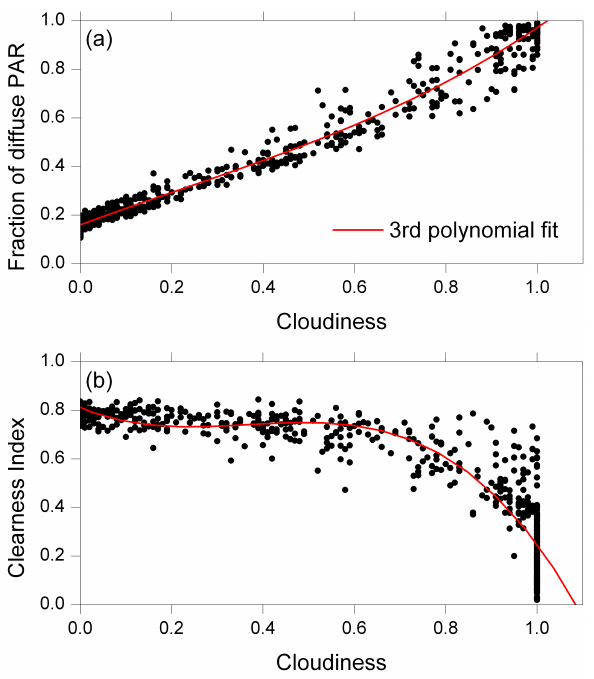
Fig. 6. Relationships between fraction of diffuse PAR (a) , clearness index (b) and cloudiness, respectively for 3rd polynomial fits ( n = 663, (a) r 2 = 0 . 98, (b) r 2 = 0 . 86, p < 0 . 01).